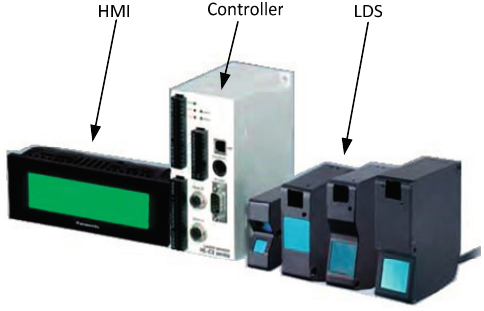
Figure 1. Laser Displacement Sensor (LDS).